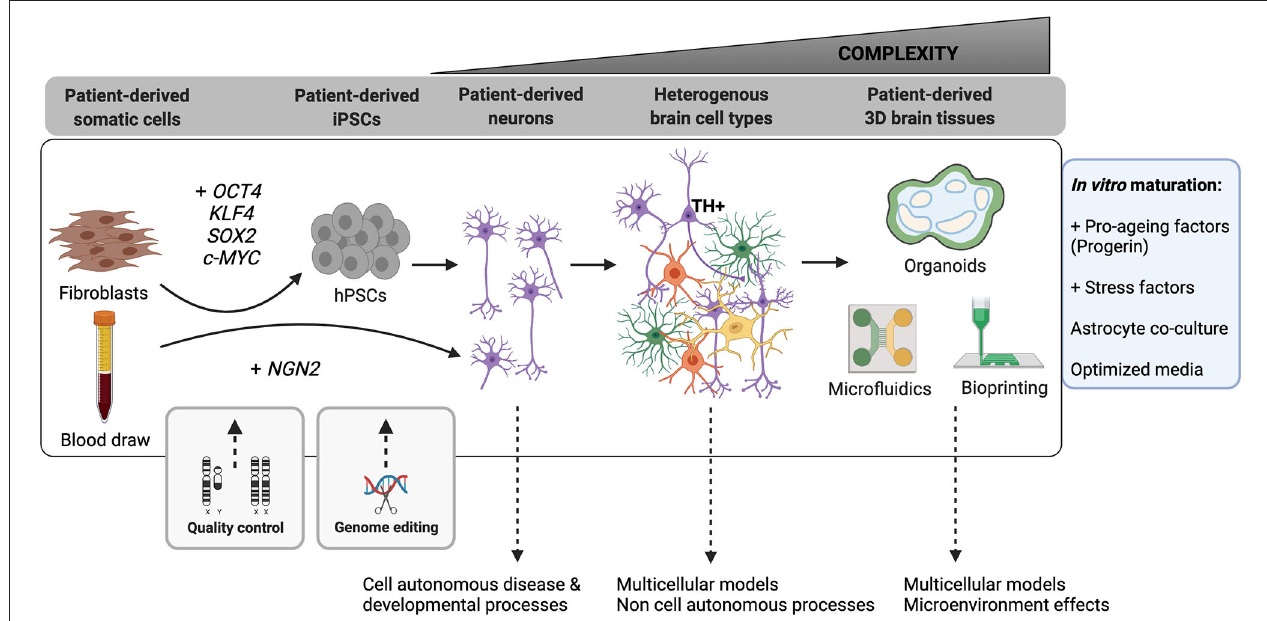
FIGURE 2 | Advances in hPSC-based neurological modeling are increasingly improving the complexity of human neural cell types and circuits we can model. Somatic cells from multiple human patient sources (fibroblast skin cells, blood, urine) can now be used to produce induced human pluripotent stem cells (hPSCs) by over-expression of typically four key pluripotency transcription factors ( OCT4, SOX2, KLF4, c-MYC ). Similarly, induced neurons can be directly established by over-expression of neuronal identity genes like NGN2 . It is essential to regularly perform quality control assays (detailed in the main text) to ensure maintenance of a high-quality pluripotent state in reprogrammed hPSCs. This stage also offers a critical period for genome editing (e.g., CRISPR-Cas9) in which to introduce mutations of interest or create isogenic control lines. As a field, we can reproducibly generate fetal-stage excitatory and inhibitory neurons in 2D and 3D cell cultures. These cultures permit analysis of cell-autonomous mechanisms of development and disease, especially in the presence of a disease-causing mutation. Recent efforts have increased our ability to generate additional specialized brain-resident cells (“Heterogenous brain cell types”) and to produce more mature neurons (purple = excitatory and inhibitory neurons with elaborate neurite networks; green = astrocytes; orange = oligodendrocytes; yellow = microglia). These heterogeneous cultures permit modeling of non-cell autonomous processes. Offering the most advanced level of complexity in hPSC models are 3D brain tissue engineering approaches, including organoids (rounded enclosed objects = ventricular zones; blue shading = neural stem and progenitor cells; green shading = neurons and other differentiated cell types) and bioprinted constructs, which can incorporate microfluidic channels for advanced microenvironmental control. Studies have also begun to incorporate vasculature and components of the blood-brain barrier into microfluidic and organoid models. The box to the right outlines recent and developing strategies for promoting neuronal maturation and aging in 2D and 3D